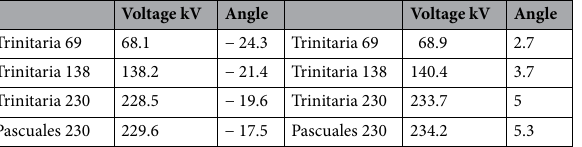
Table 12. Magnitude and angle variation before (left) and after (right) entering Trinitaria static load